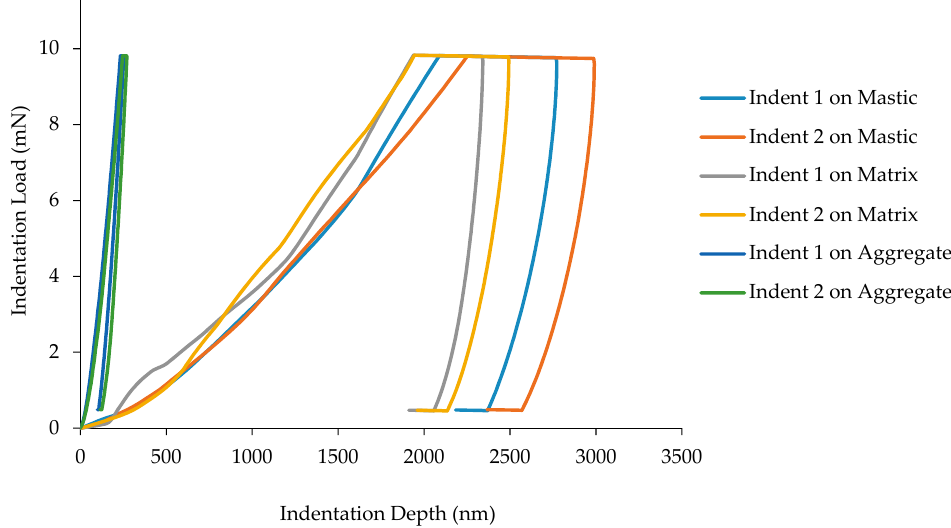
Figure 7. Load-displacement curve for all phases in AC without hydrated lime.